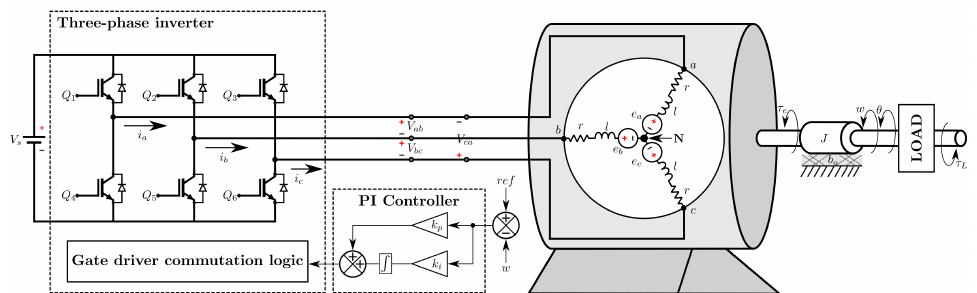
Figure 1. Three-phase motor